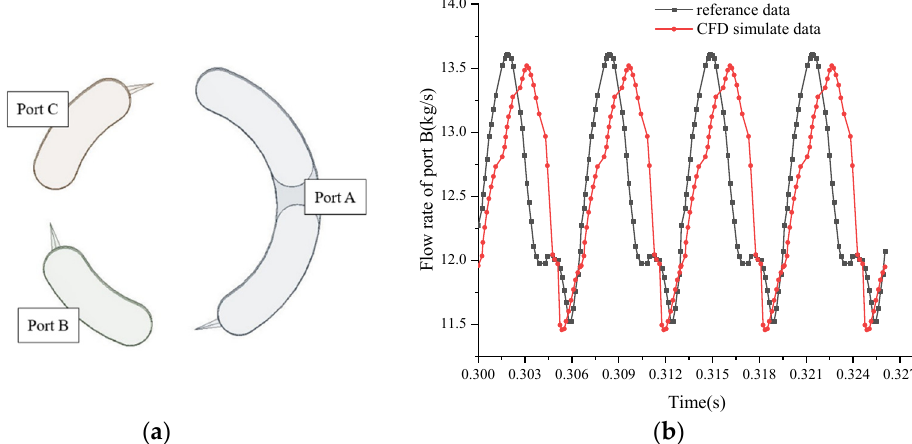
Figure 4. Comparison between simulation and data in the work of [23]. ( a ) Flow field of valve plate. ( b ) Flow rate comparison of port B.